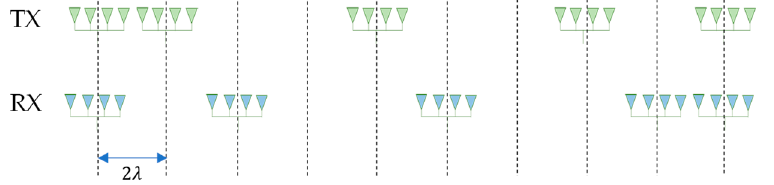
Figure 13. MRA MIMO Configuration. The ratios of the spacing among subarrays are 1:3:3:2 and 2:3:3:1. Each TX and RX subarray is comprised of 4 uniform arrays.